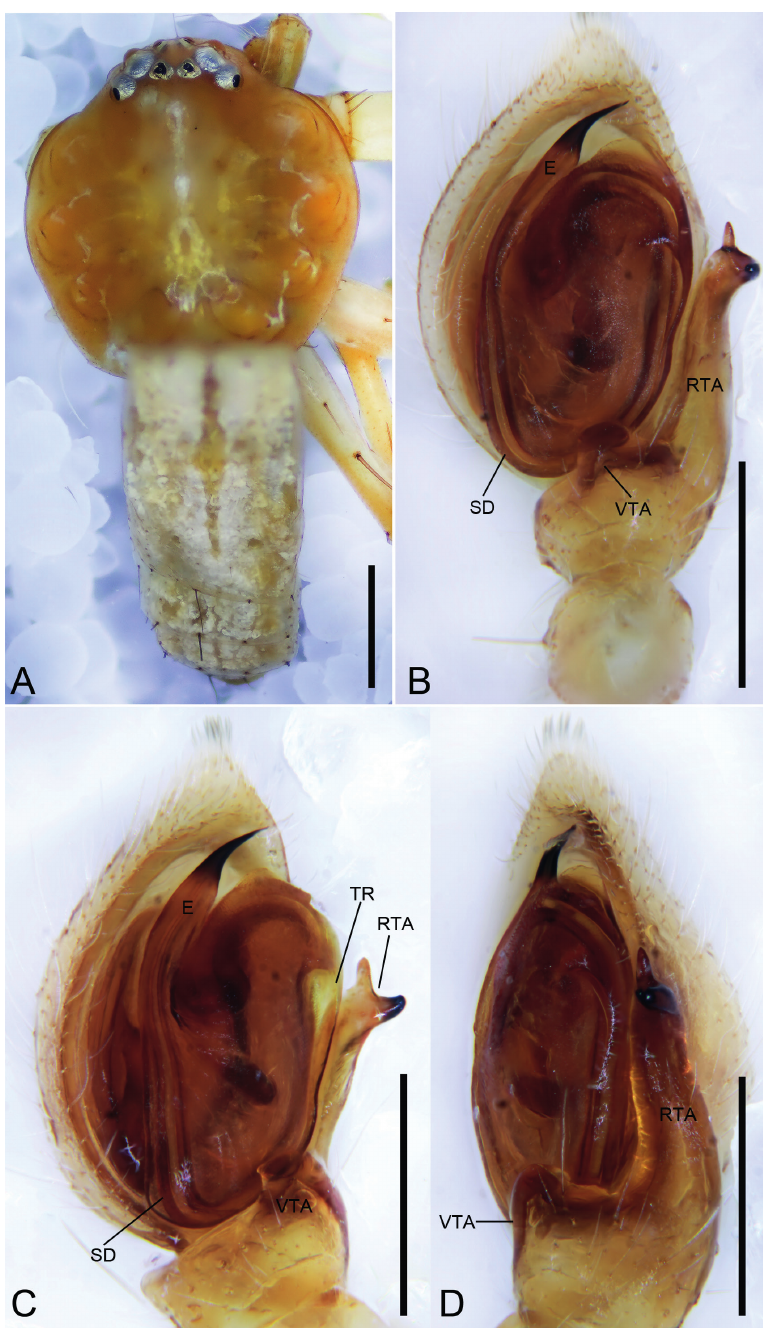
Figure 9. Oxytate bicornis Liu, Liu & Xu, 2017, male. A habitus, dorsal view B palp, ventral view C same, prolateral view D same, retrolateral view. Abbreviations: E – embolus, RTA – retrolateral tibial apophysis, SD – sperm duct, TR – tegular ridge, VTA – ventral tibial apophysis. Scale bars: 1 mm ( A ), 0.5 mm ( B–D